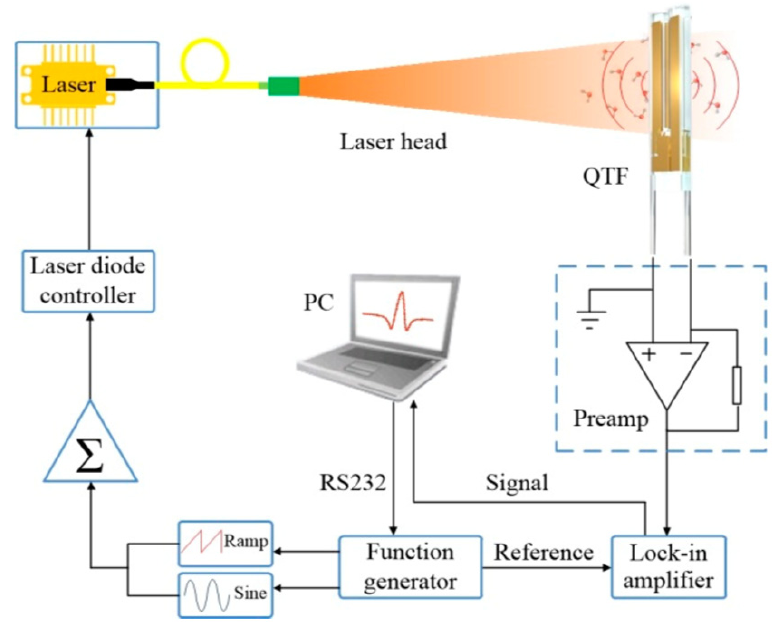
Figure 5. Experimental setup of the QEPTAS sensor system. Reprinted/adapted with permission from Ref. [104]. Copyright 2019, copyright MDPI.